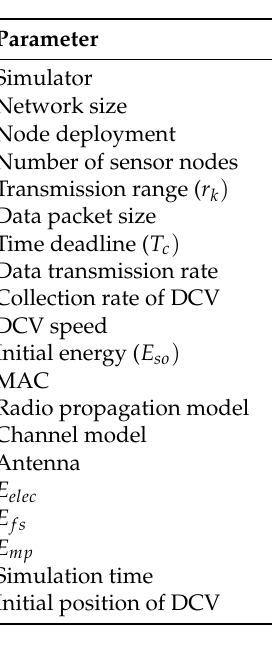
Table 4. Simulation